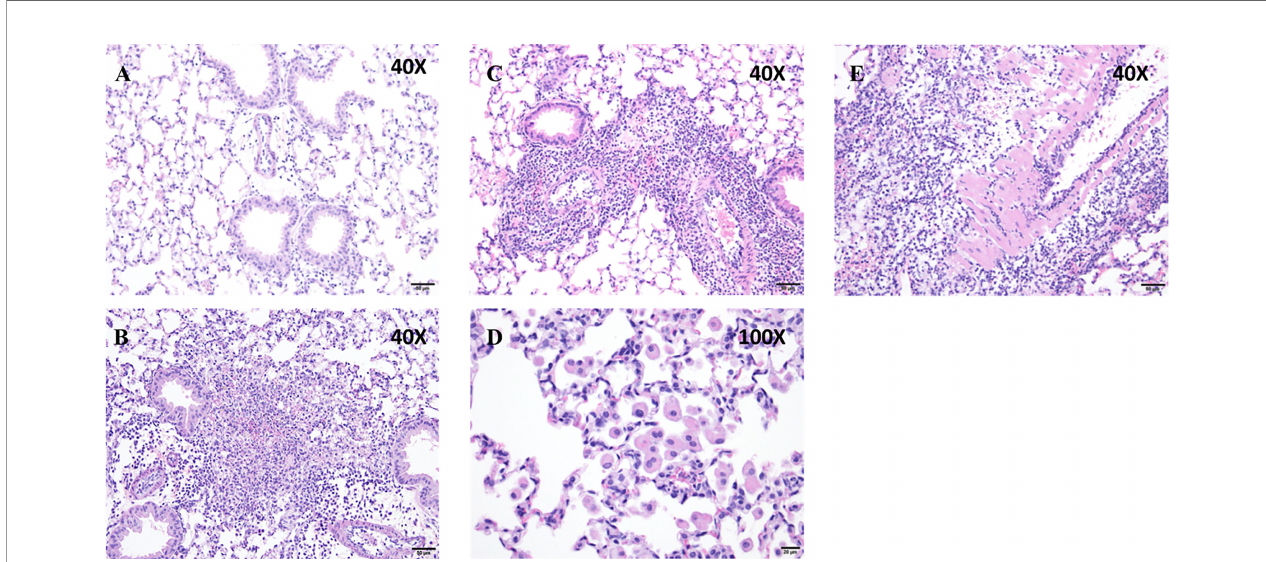
FIGURE 2 | Puma protects against tissue in fl ammation. (A, B) Puma +/+ mice exhibited mild peribronchioloar in fl ammation with edema and neutrophils and macrophages. (C – E) Puma -/- mice exhibited moderate peribronchiolar/perivascular in fl ammation, abundant neutrophils, macrophages, vasculitis (eosinophilic material, vascular thickening). Scale bars: A – C , E , 50 m m; D , 20 m m. Images shown are representative of the pathology described in the results from 3 sections each from 5 mice.